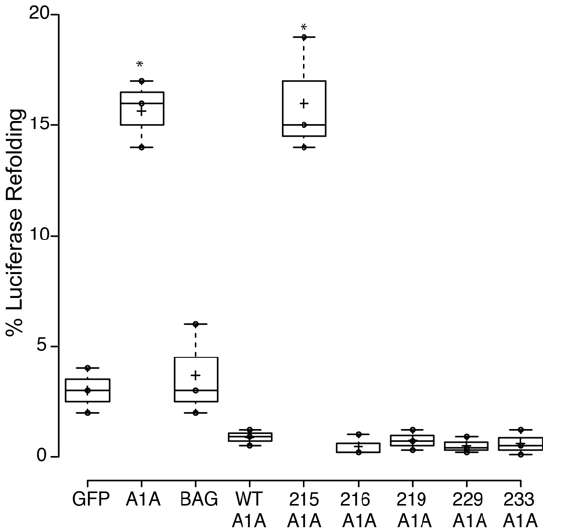
Figure 14. BAG-1 natural variants alter the refolding properties of HSPA1A (A1A). All mutations inhibit refolding of heat-denatured luciferase by HSPA1A at a level similar to the wild-type (WT) BAG-1 protein, except the K215E variants, which show significant changes as compared to the wild-type protein. Centerlines show the medians; box limits indicate the 25th and 75th percentiles as determined by R software; whiskers extend 1.5 times the interquartile range from the 25th and 75th percentiles; crosses represent sample means; dots represent individual data points. Each experiment was repeated three times. Significantly different values are denoted with a star (*). The actual p -values between all comparisons are provided in Supplementary Materials Table S2.